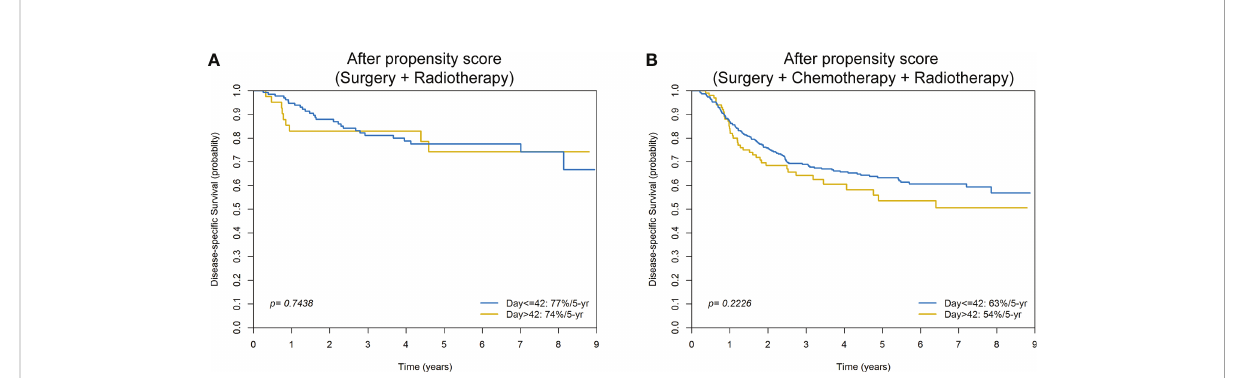
FIGURE 3 Kaplan-Meier plots comparing 5-year disease-speci fi c survival of surgery-to-radiotherapy intervals ≤ 42 days versus >42 days for patients with oral cavity squamous cell carcinoma treated with surgery plus radiotherapy (A) or surgery plus chemotherapy plus radiotherapy (B) after propensity score